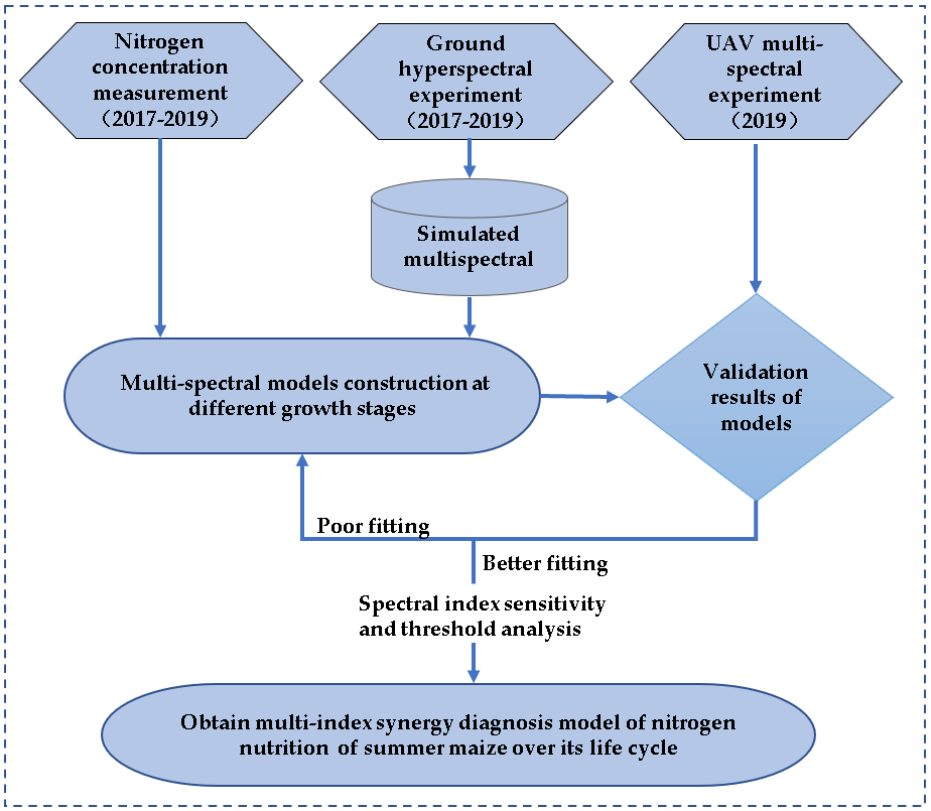
Figure 2. Flow chart of diagnosis of nitrogen nutrition status.